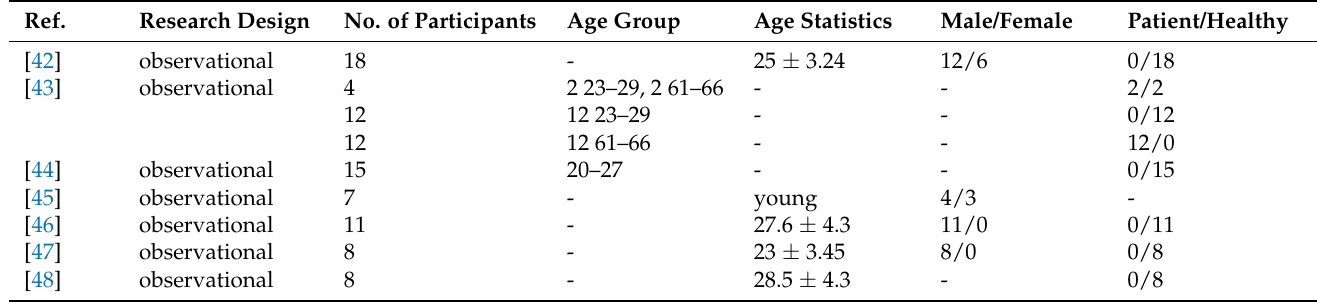
Table 3. Participant demographics for studies on fall detection. - = no information.